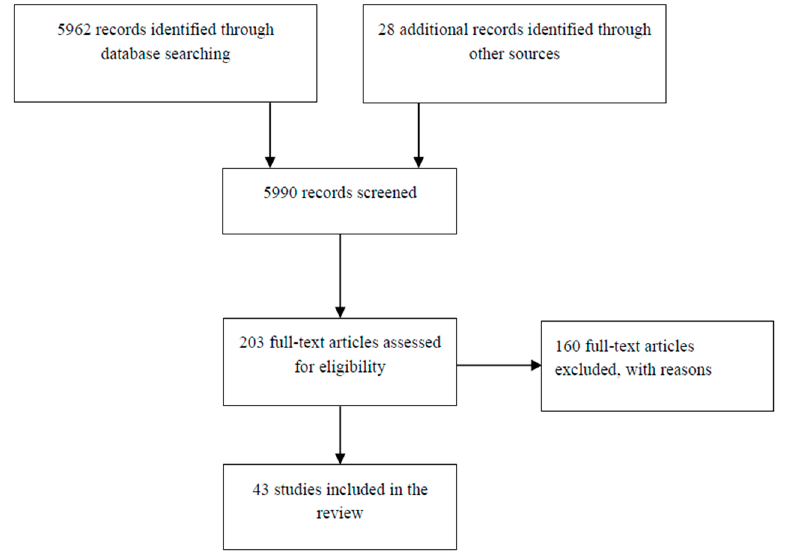
Figure 2. PRISMA Flow Diagram.